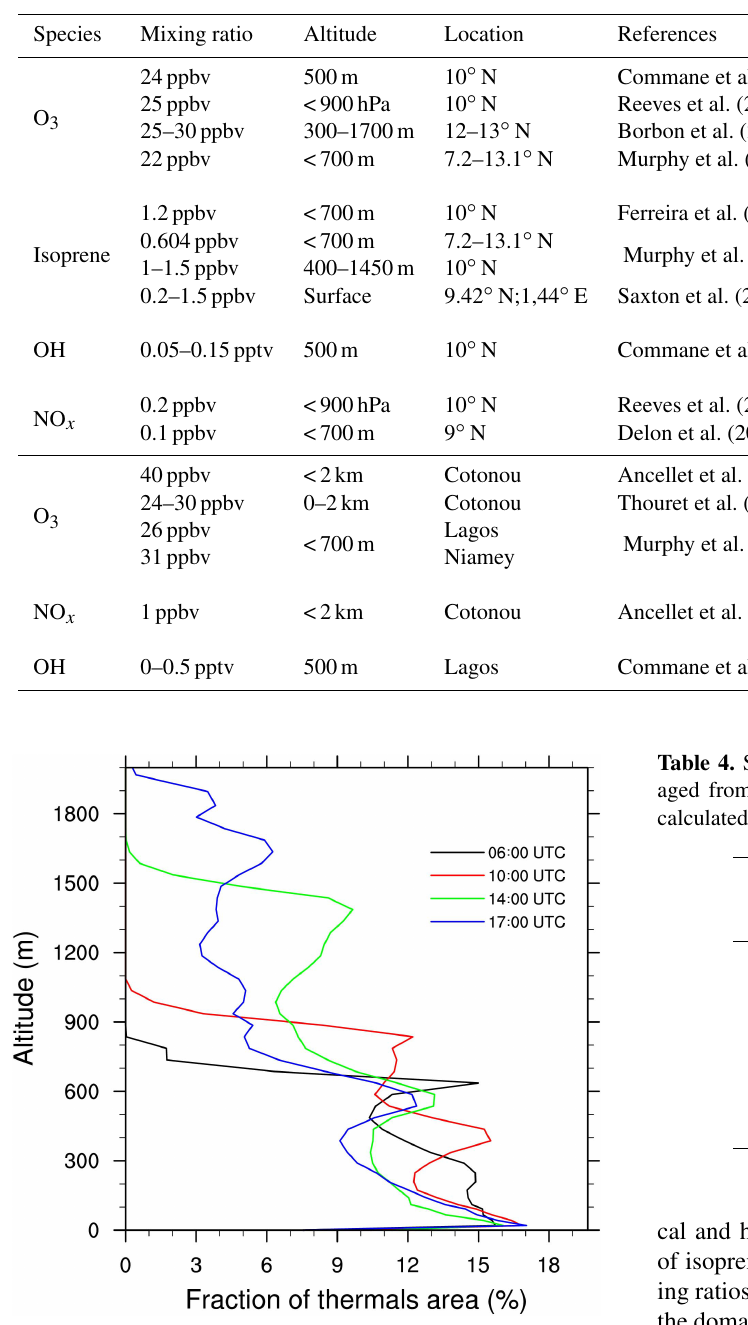
Table 3. Measurements collected during the AMMA campaign over forested areas (upper part) and over cities (lower part). The last column corresponds to the concerned period.